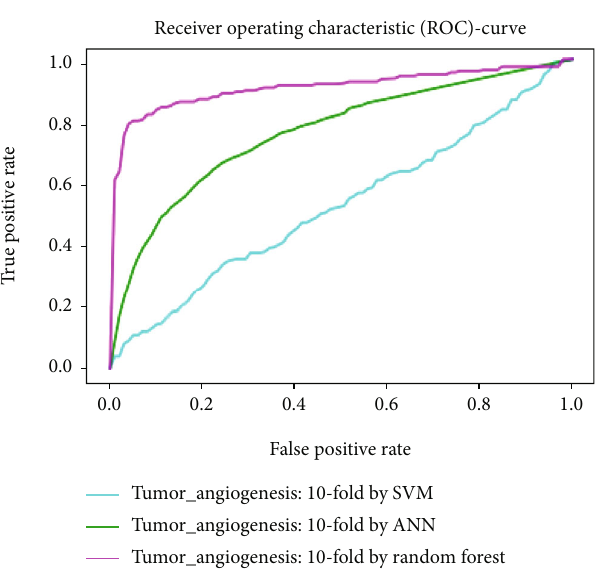
Figure 12: Comparison based on 5-folds.